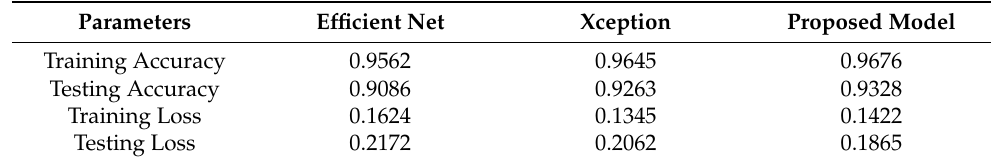
Table 9. Training and testing loss and